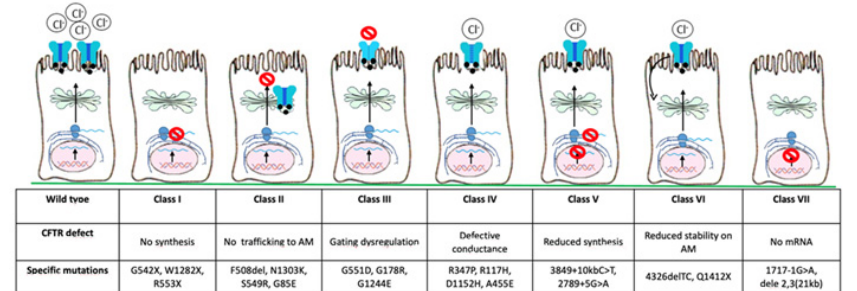
Figure 2. CFTR gene mutations are classified into seven main classes based on the defect of CFTR gene. AM, apical membrane.